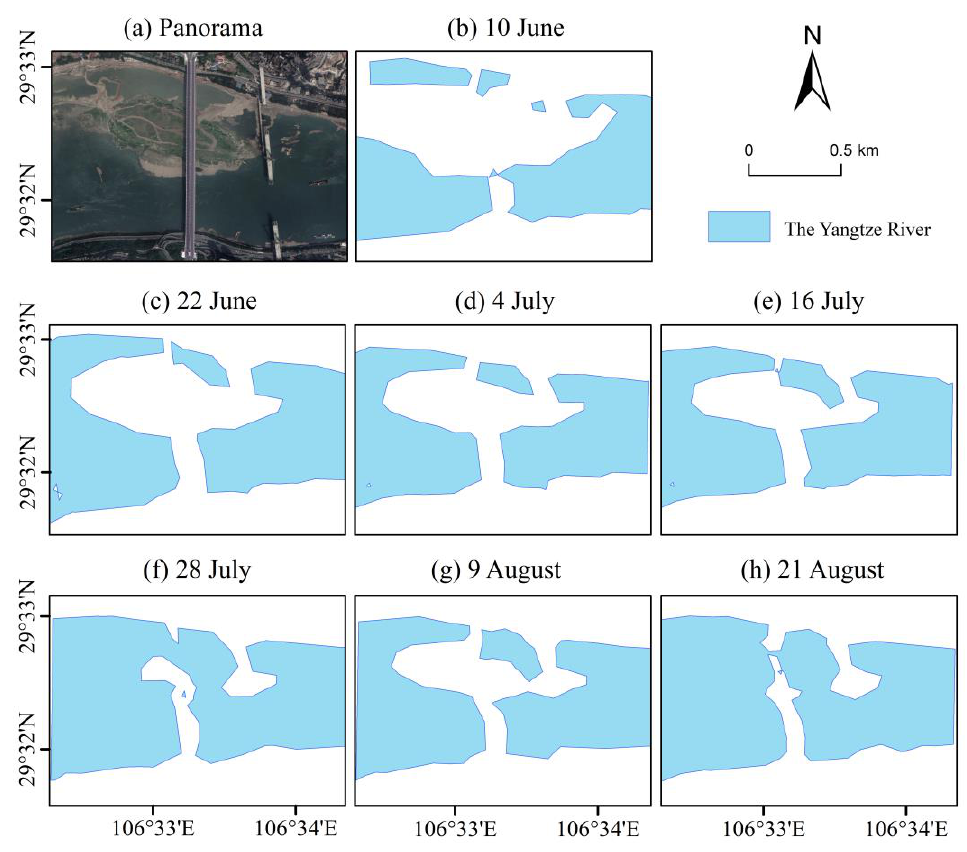
Figure 8. Water surface distribution of Shanhuba in different periods: ( a ) panorama of Shanhuba, ( b ) 10 June, ( c ) 22 June, ( d ) 4 July ( e ) 16 July, ( f ) 28 July, ( g ) 9 August, and ( h ) 21 August 2020.